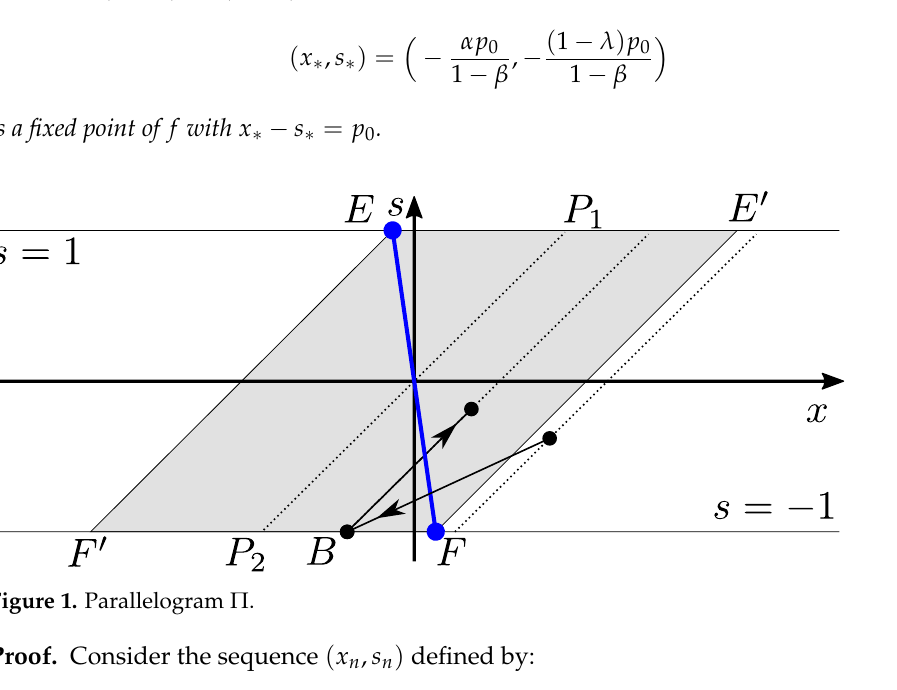
Figure 1. Parallelogram Π